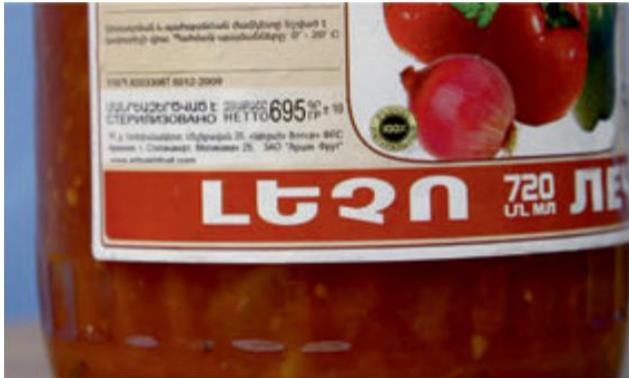
Figure 3. An illegal brand of the "Artsakh Fruit CJSC" product written “Stepanakert, Armenia in the Armenian language.